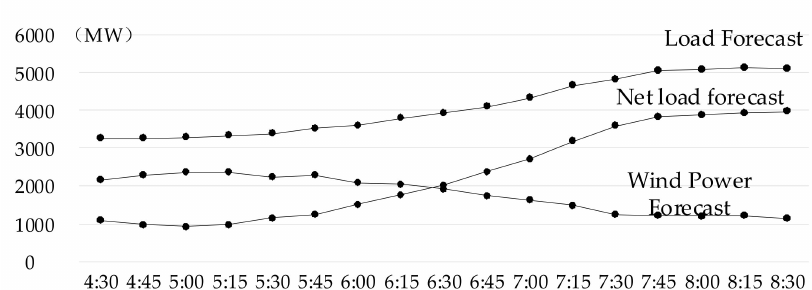
Figure 4. Forecast data of load and wind power.